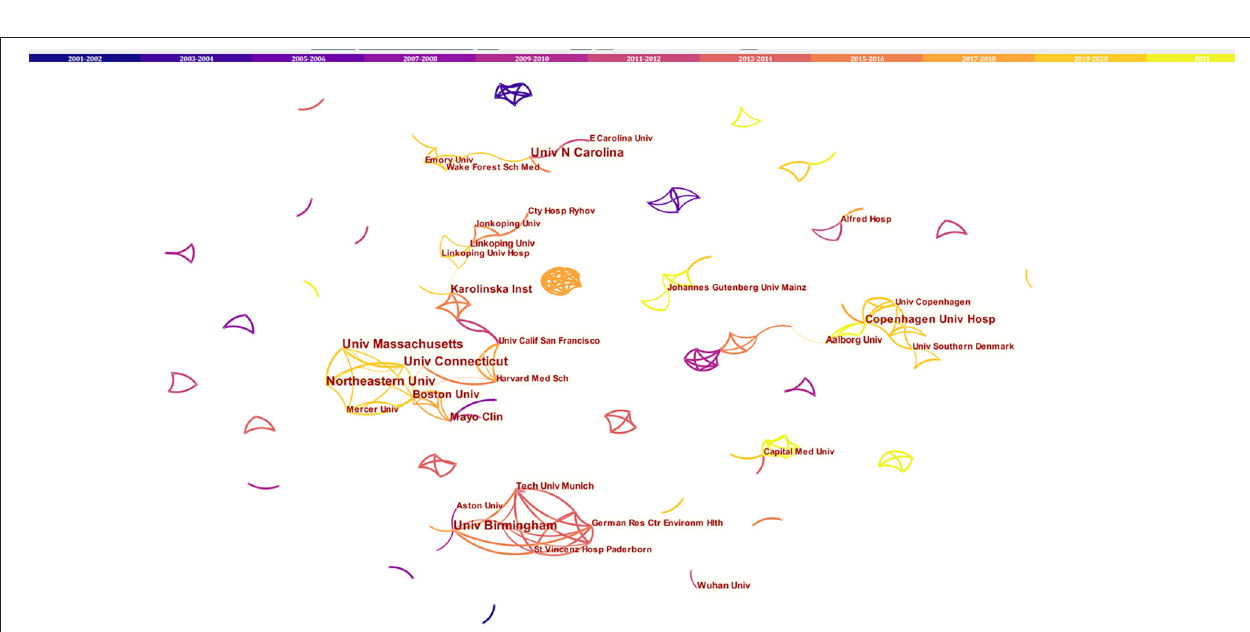
FIGURE 4 | The network of countries/territories engaged in the research about atrial fibrillation and depression. In the networks, the larger the node was, the more contribution the country/territory had made to that field. The nodes with higher centrality ( > 0.1) are highlighted with purple rings. The color of the line represents the time of first co-occurrence. The thicker the line is, the greater the connection strength is (calculation method based on cosine).